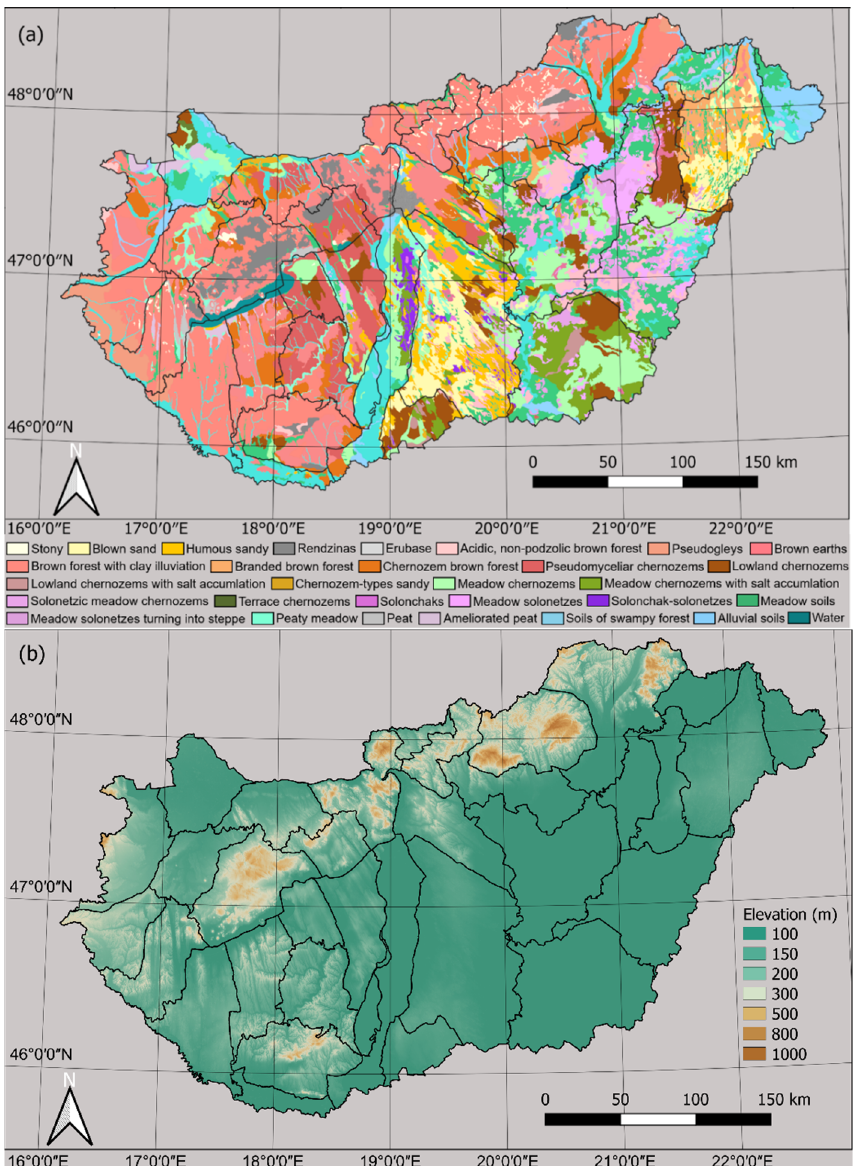
Figure 1. Agro-ecological zones of Hungary, used for stratifying crop classification, overlain on ( a ) a soil map where individual colours represent different soil types [44] (see Figure S1 for higher resolution) and ( b ) a digital elevation model (see Figure S2 for higher resolution).